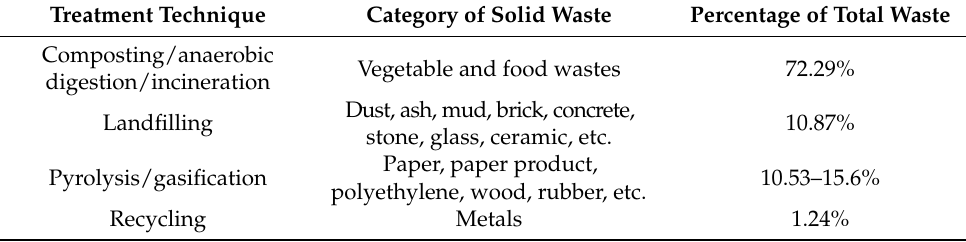
Table 9. Potential treatment of